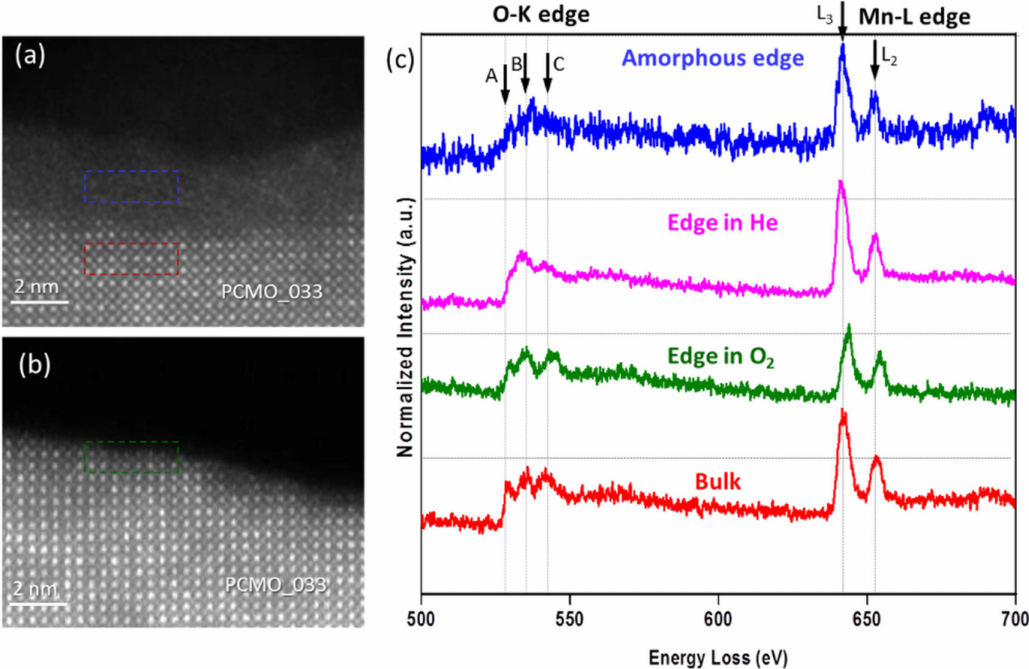
Figure 4. HRSTEM images of PCMO (x = 0.33) before ( a ) and after ( b ) crystallization under electron beam in oxygen, respectively. ( c ) EELS spectra (0.1 eV / channel) collected from the areas marked with di ff erent colors in ( a ) and ( b ). Spectral features marked with A, B, C, L 2 and L 3 are discussed in the